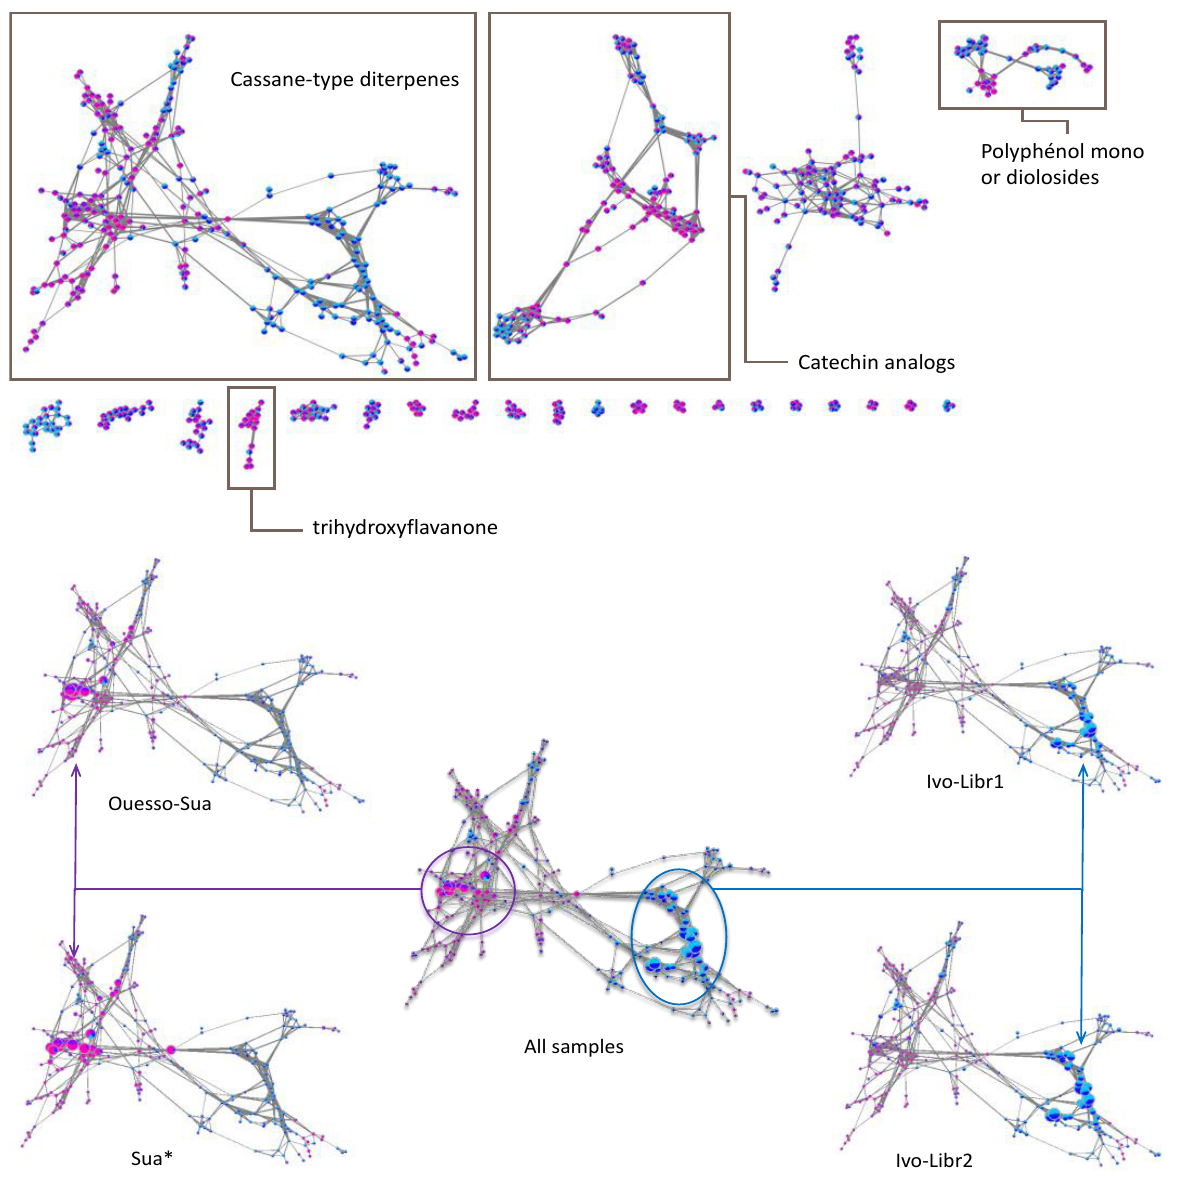
Figure 6. On the ( top ), attribution of the different sub-clusters using GNPS databases, on the ( bottom ), focusing on the cassane-type diterpenes cluster where nodes sizes are proportional of the abundances. Each node is a pie-chart with Sua * in pink, Ouesso-Sua in violet, ivo-Libr1 in light blue, ivo-Libr2 in dark blue. Two other nodes linked to [ A1 ] are more abundant in E. suaveolens (Figure 5), with m / z 434.2549 RT = 14.53 min (CS 0.72) and m / z 434.2855 RT = 17.16 min (CS 0.72)